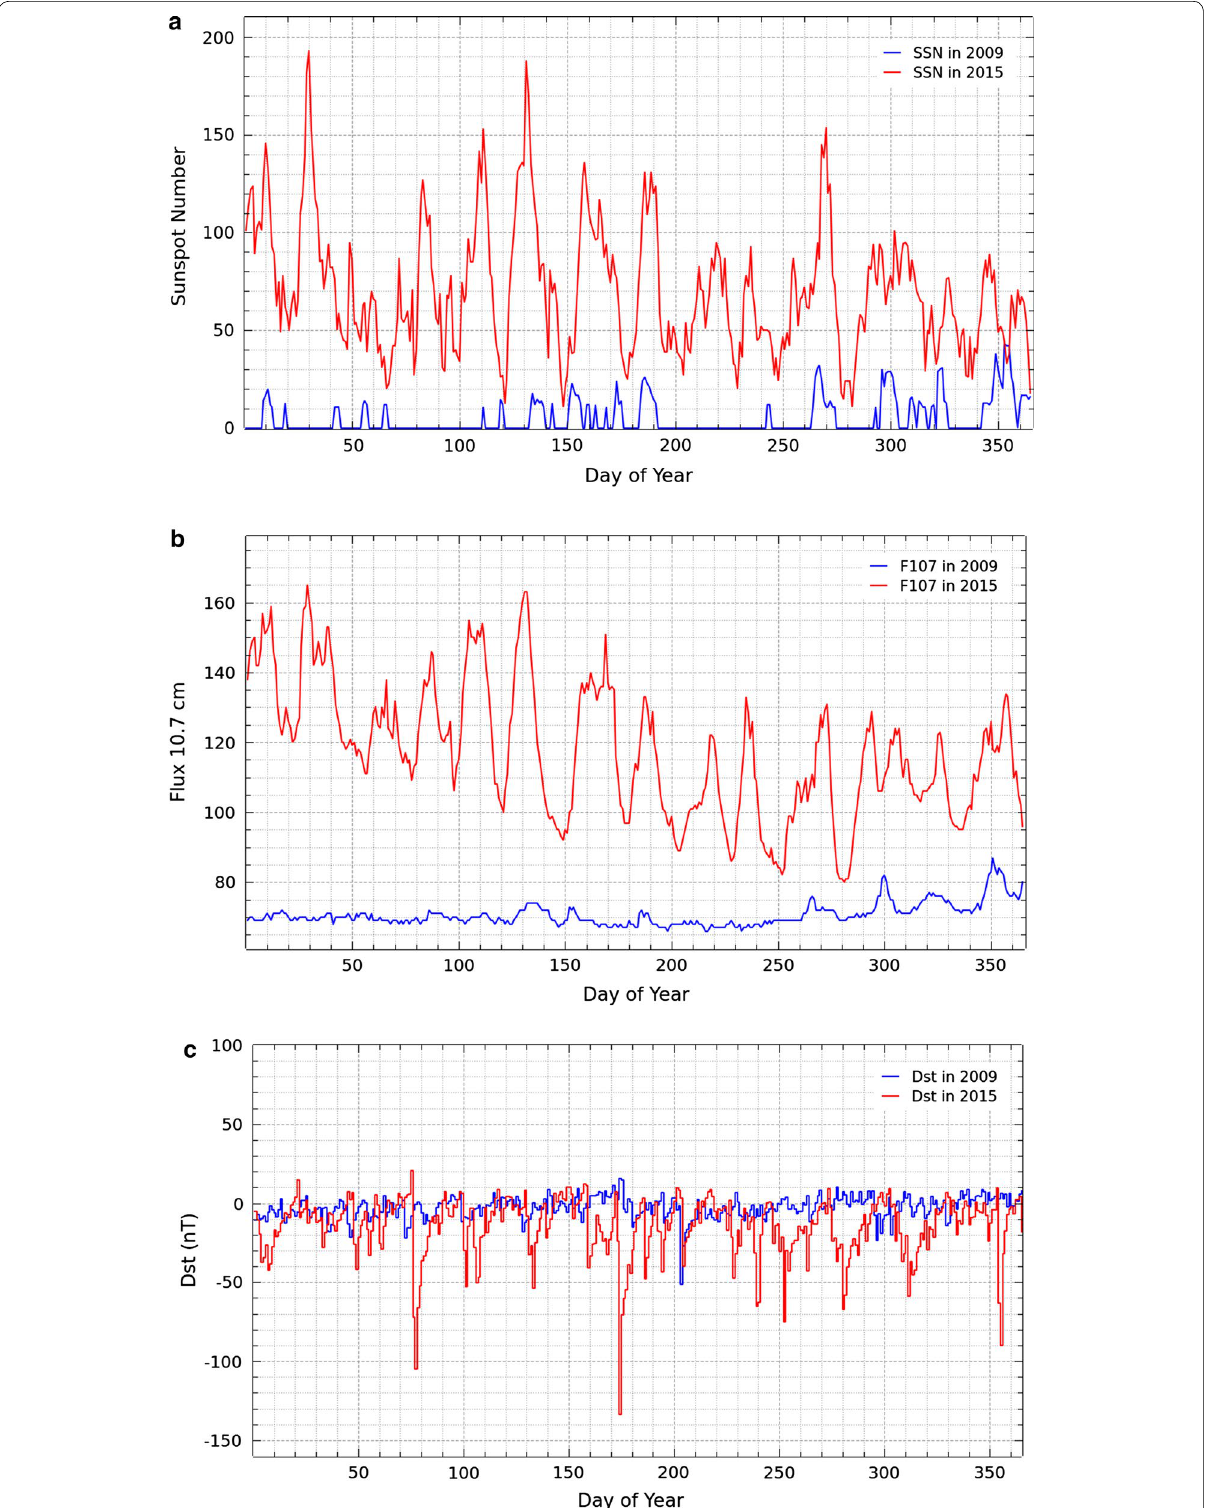
Fig. 2 SSN, F10.7, and Dst values in 2009 and 2015 are presented by the blue and red lines, respectively. a Sunspot numbers. b Solar flux at 10.7 cm. c Dst